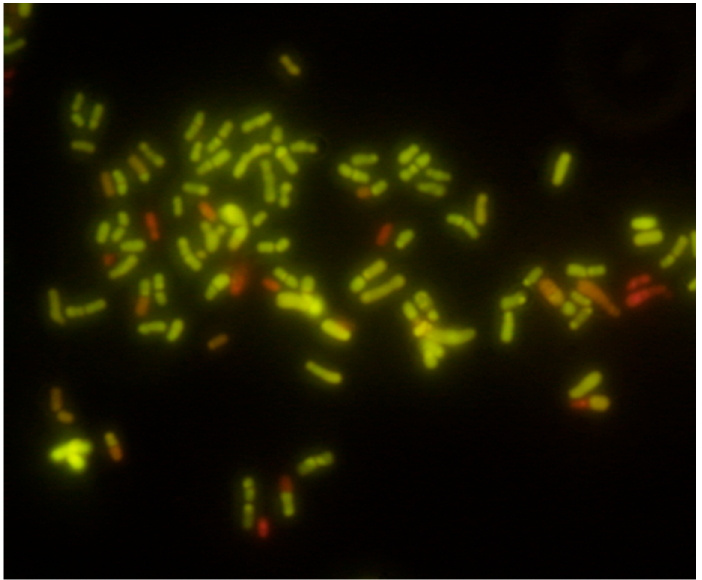
Figure 1. Bifidobacterium animalis subsp. lactis INL1 seen under fluorescence microscopy (1000× mag- nification) after staining with a cell viability probe. Live cells are stained in green, whereas non- viable cells are shown in red. An overnight (18 h, 37 °C, anaerobiosis) culture of the strain was stained with LIVE/DEAD ® BacLight™.